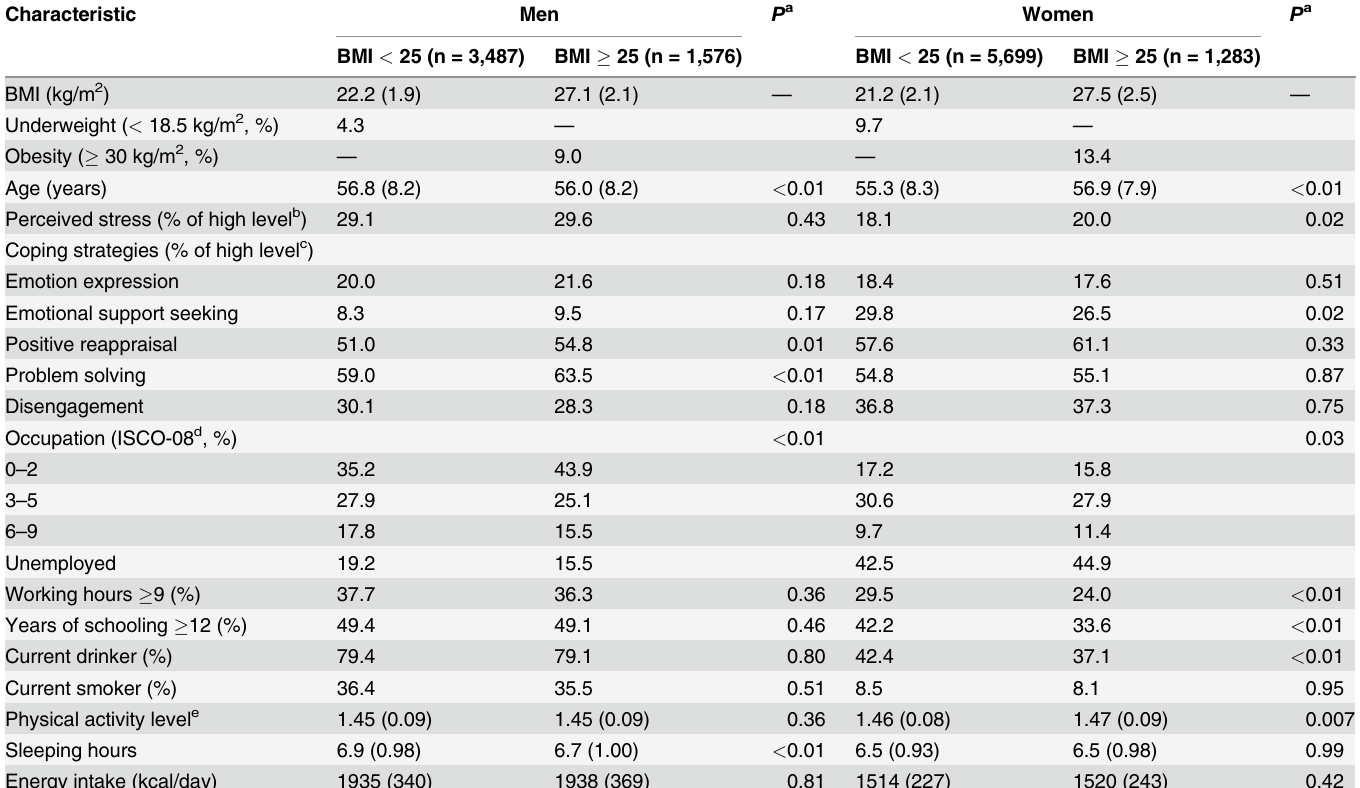
Table 1. Characteristics of study subjects (5,063 men and 6,982 women) by body mass index (BMI, < 25 and (cid:1) 25 kg/m 2 ) — Japan, 2005 –